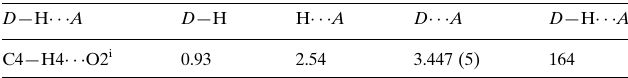
Hydrogen-bond geometry (A˚ , (cid:2)